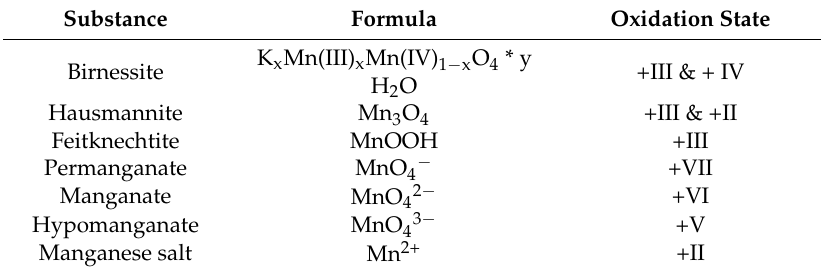
Table A1. Overview of substances mentioned during this